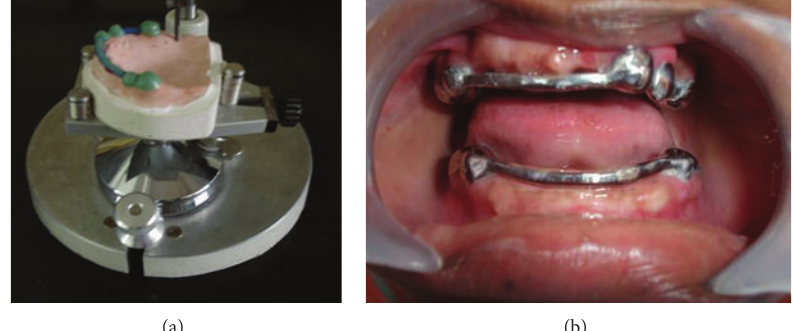
Figure 6: Milling of wax pattern on the cast (a) and milled metallic framework cemented to the teeth intraorally (b).